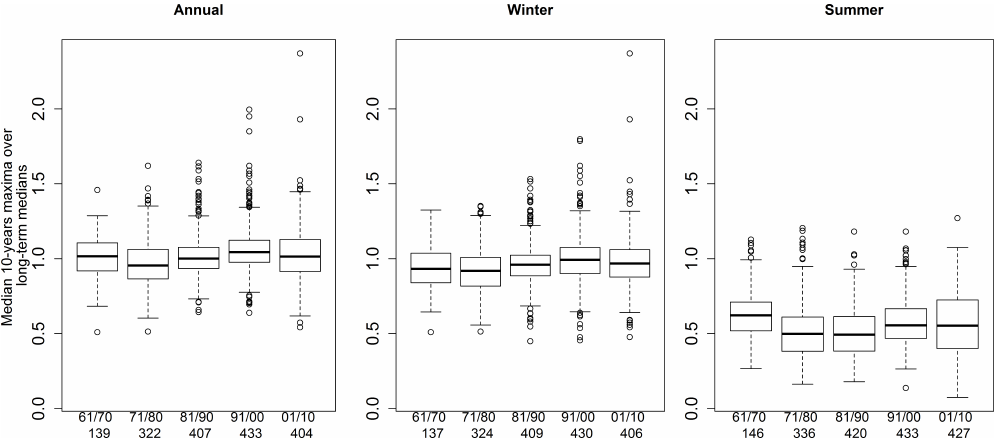
Fig. 3. Median ratio of annual and seasonal maximum peak river flow over long-term median of the annual maximum, shown separately for each decade. The number of stations with at least 7years of data used to compute the proportions is indicated below the x axis.